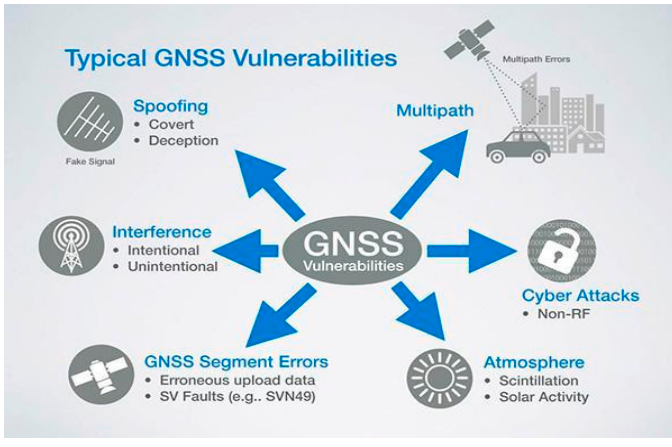
Figure 3. Typical GNSS vulnerabilities [22].